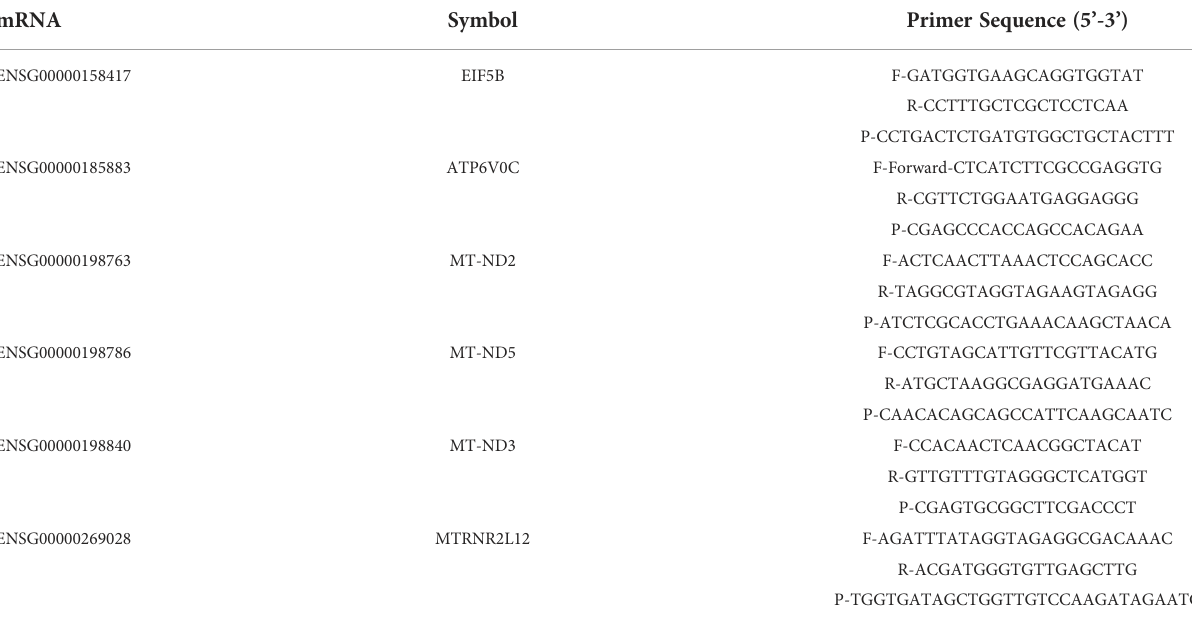
TABLE 2 Primer list.